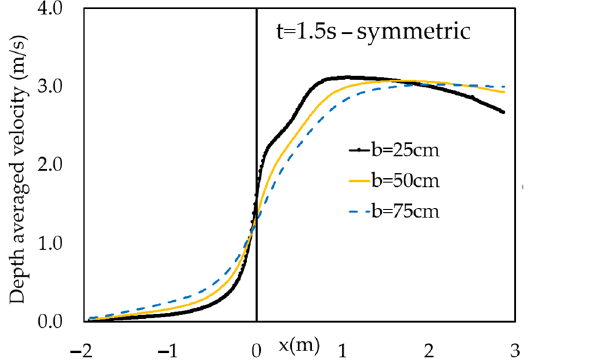
Figure 6. Water depth profiles at central axis of partial dam collapsed.